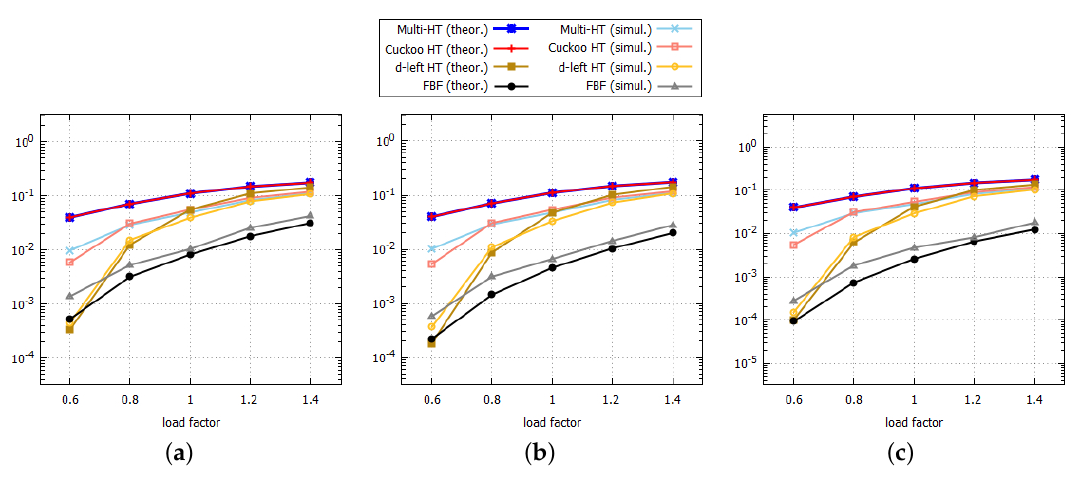
Figure 7. Comparison on search failure rates: ( a ) 8k; ( b ) 32k; ( c )